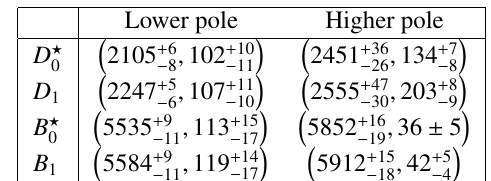
Table 1. Predictions of two states in various I = 1 / 2 channels in the heavy meson sector. Here ( M , Γ / 2) denote the mass and the half-width, respectively, in units of [MeV]. From Ref. [39].